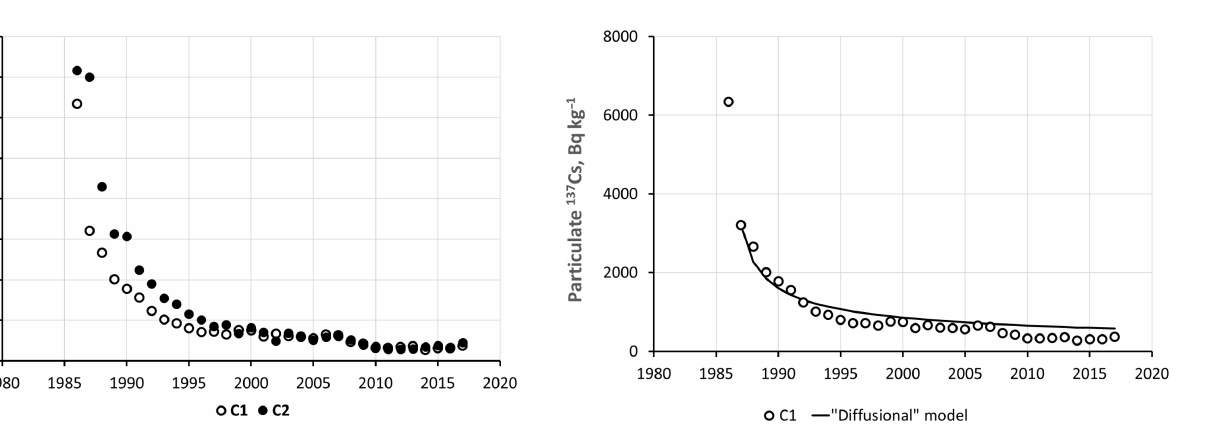
Figure 3. Reconstructed time dependencies of particulate 137 Cs ac- tivity concentrations (decay-corrected for 1986) in the Upa River based on 137 Cs vertical distributions in cores C1 and C2 collected in February 2018.